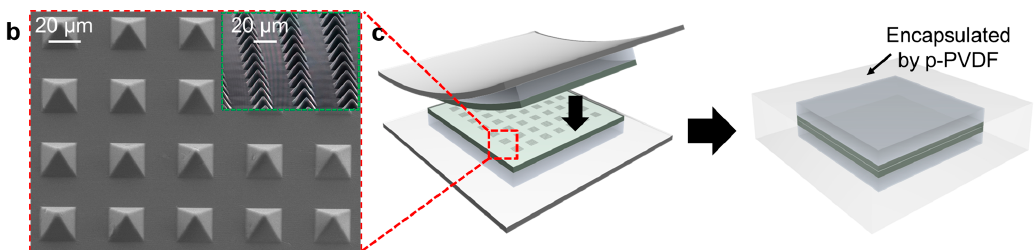
Figure 2. ( a ) Schematics for the fabrication processes of a silicon pyramid mold for the microstructure and skin-like polymer–hydrogel hybrid soft pressure sensor. ( b ) SEM images of pressure-sensitive pyramid microstructures. ( c ) Schematic for allowing the skin-like polymer–hydrogel hybrid soft pressure sensor to be air-stable using p-PVDF encapsulation films.